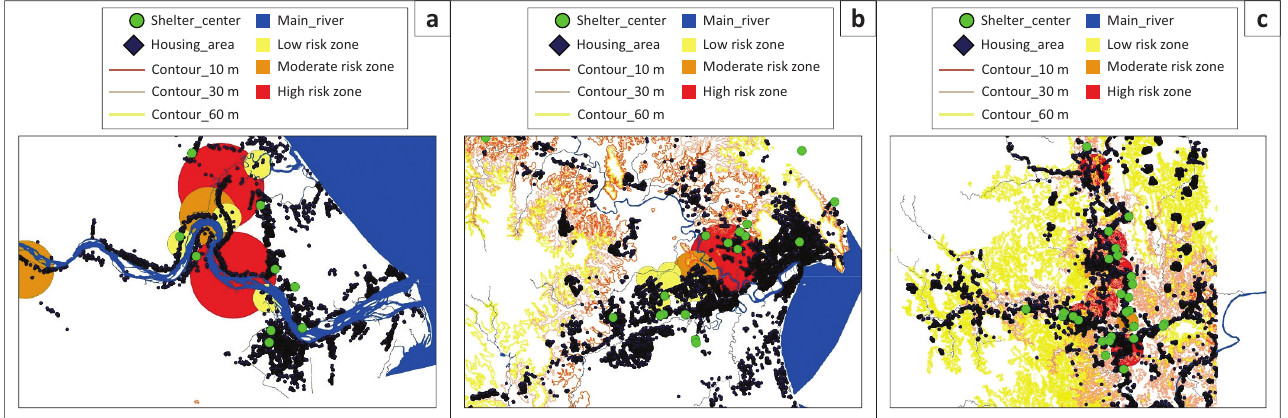
FIGURE 3: The flood disaster-affected population and shelter centres in (a) Pekan, (b) Kuantan and (c) Temerloh.